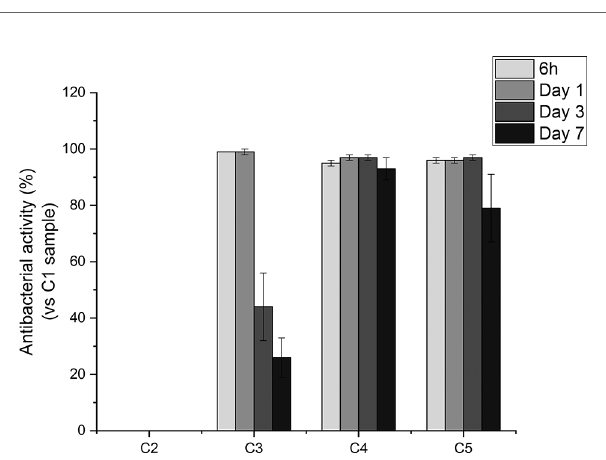
FIGURE 7 | Percentage of antibacterial activity of Ti6Al4V-coated samples (i.e., C2, C3, C4, C5) with respect to uncoated Ti6Al4V surfaces (i.e. C1) against S. aureus 24 hours after